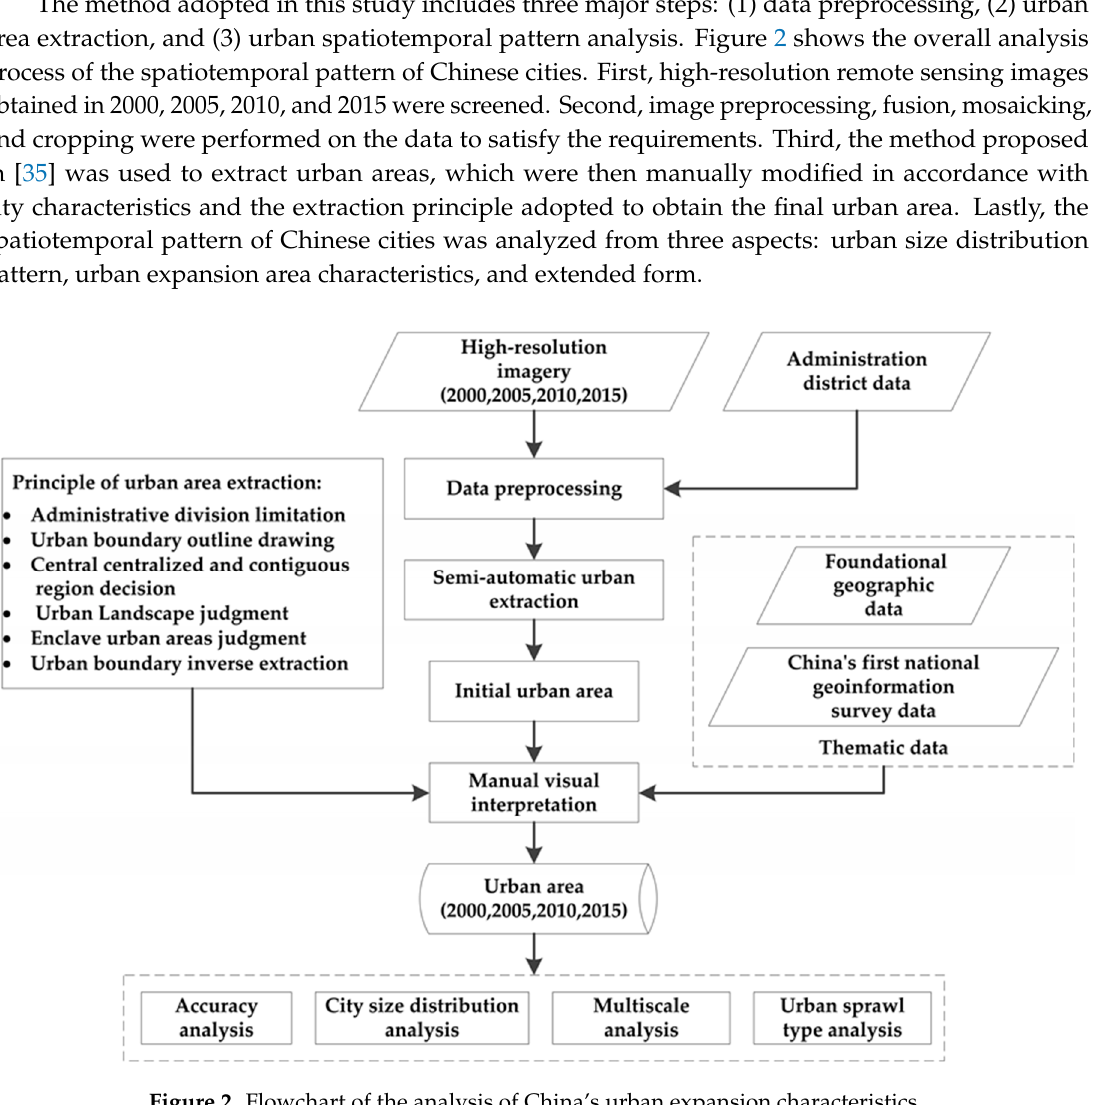
Table 1. Primary remote sensing image data used in this study.